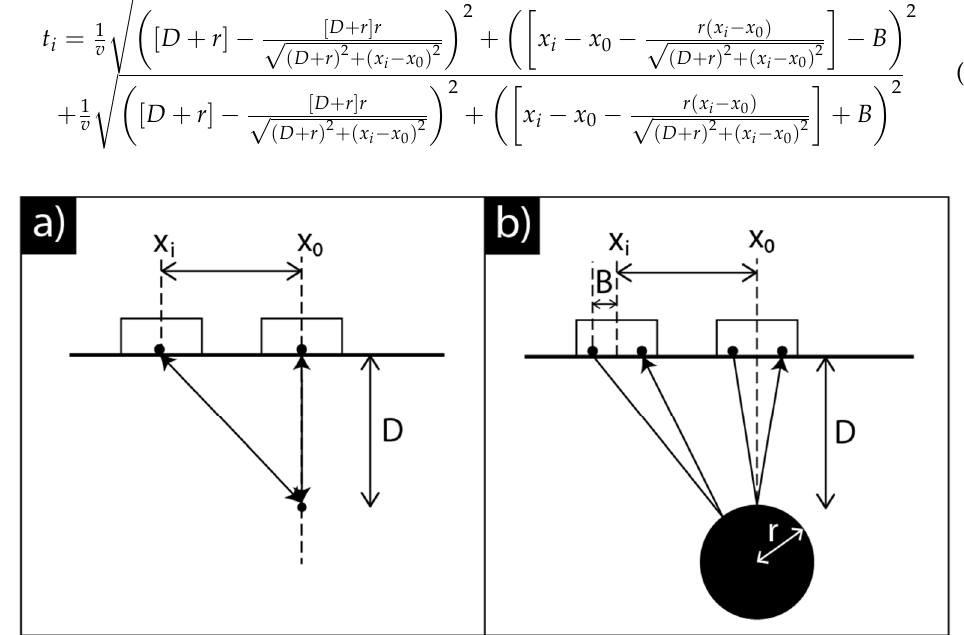
Figure 3. Subsurface situation and rays of the electromagnetic waves: ( a ) simplification with ze ‐ ro ‐ offset antenna and point object ( D : depth of object, x i : i ‐ th antenna location, x 0 : horizontal location of object) and ( b ) realistic geometry with offset between transmitter and receiver antennae (2 B ) and object with radius r .